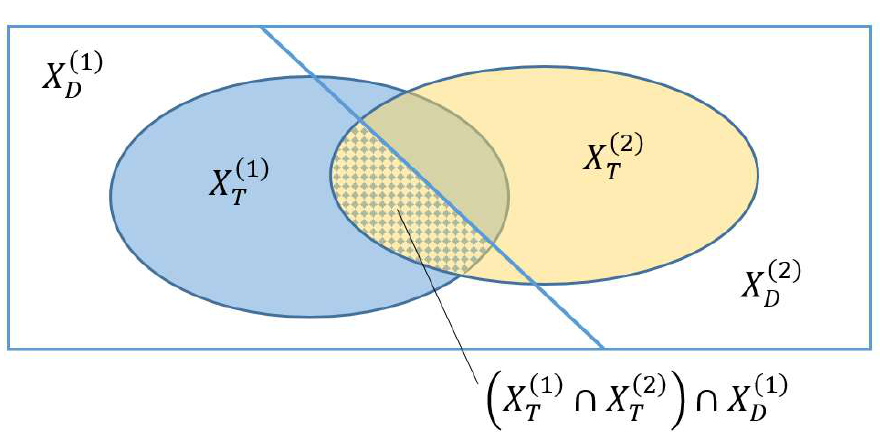
(cid:16) (cid:17) ( 1 ) ∩ X ( 2 ) ∩ X ( 1 ) X (cid:3021)((cid:2869)) ∩ 𝑋 (cid:3021)((cid:2870)) (cid:4673) ∩ 𝑋 (cid:3005)((cid:2869)) T T D .